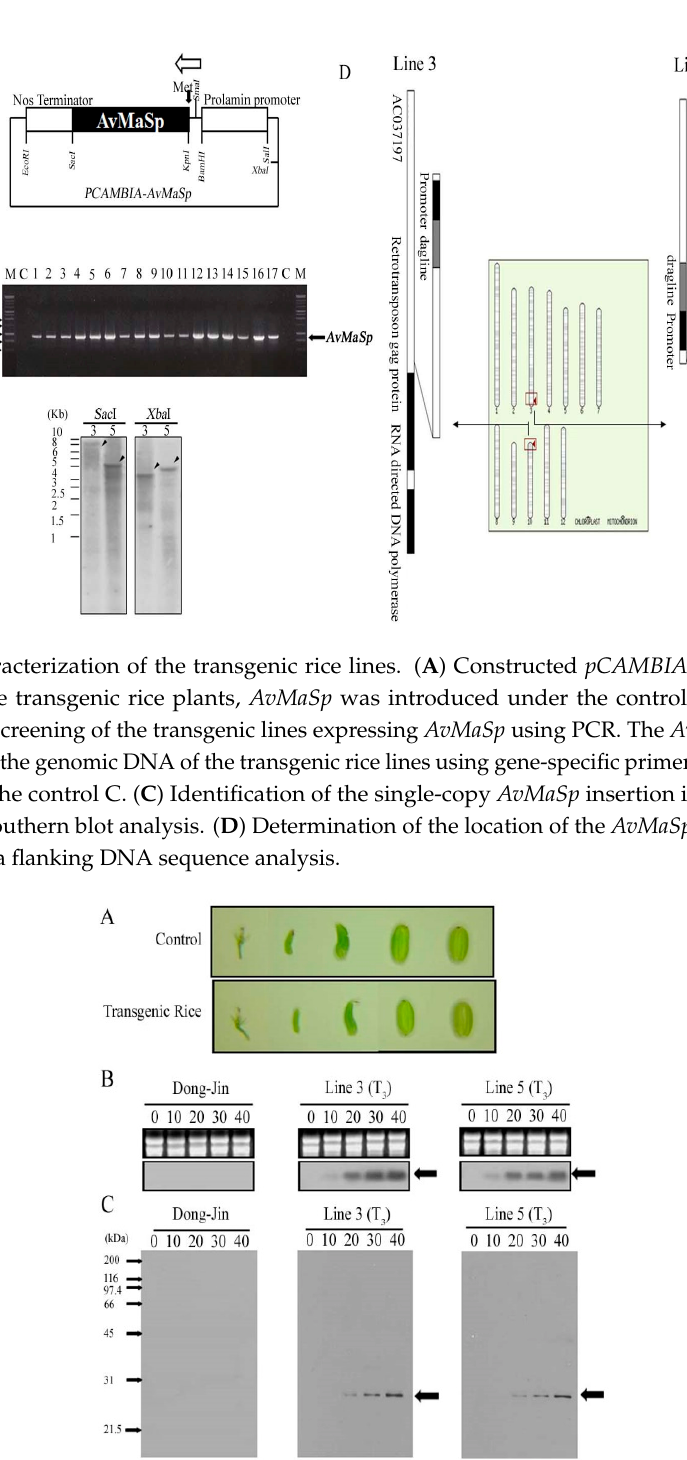
Figure 3. Immunofluorescence staining of AvMaSp in transgenic rice seeds. AvMaSp was found to be localized in the region of the embryo in the transgenic lines. Dong-Jin was used as the wild-type control. 2.2. Effects of the Transgenic Rice on Mouse Liver Weights and Blood Glucose Levels To determine whether the consumption of transgenic rice expressing AvMaSp can decrease the body and liver weights of mice, we fed either a standard diet, a wild-type rice-containing diet, or a transgenic rice-containing diet to the mice for four weeks. During the experimental period, the diet